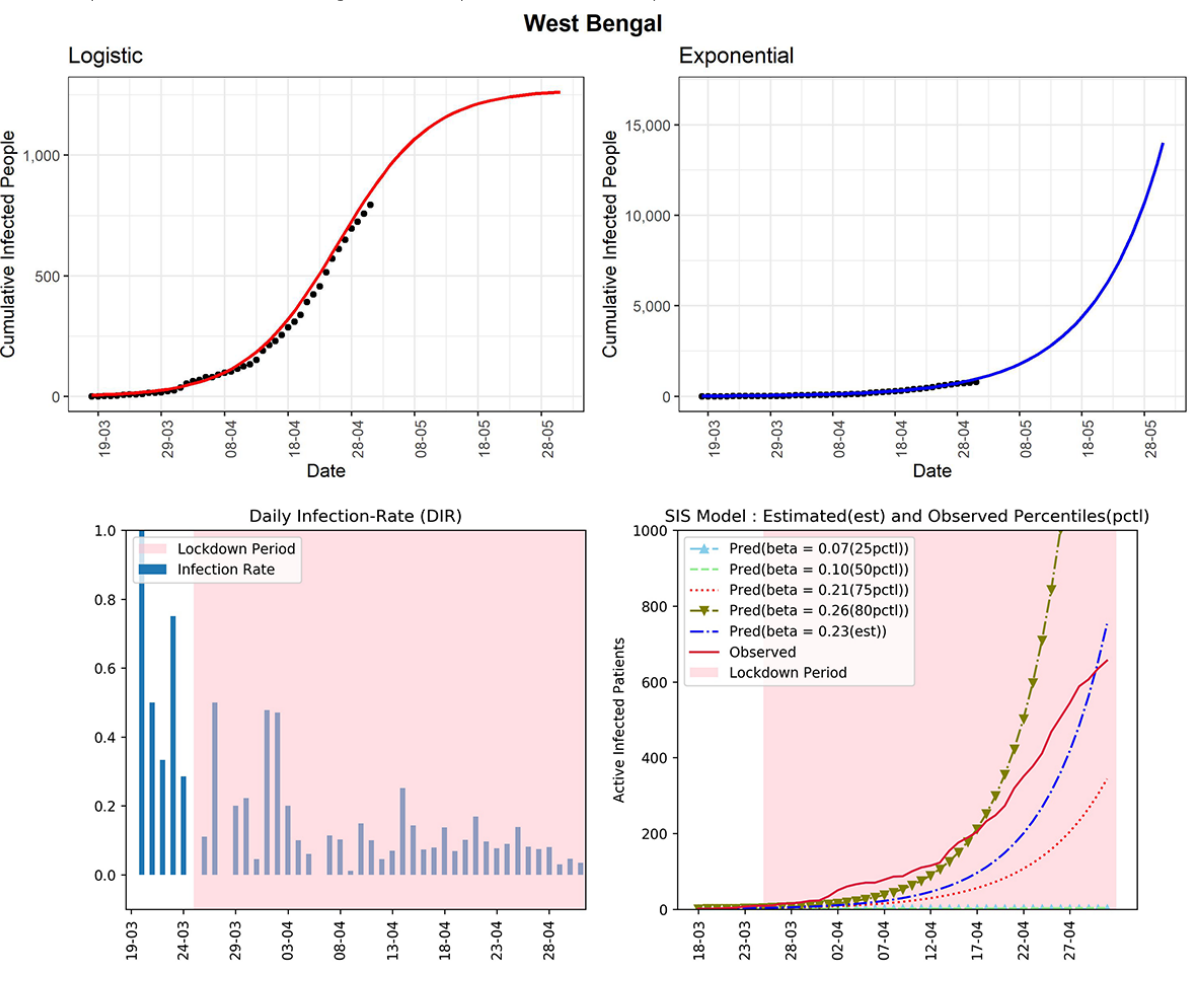
Figure 16. Graphs for the state of West Bengal. SIS: